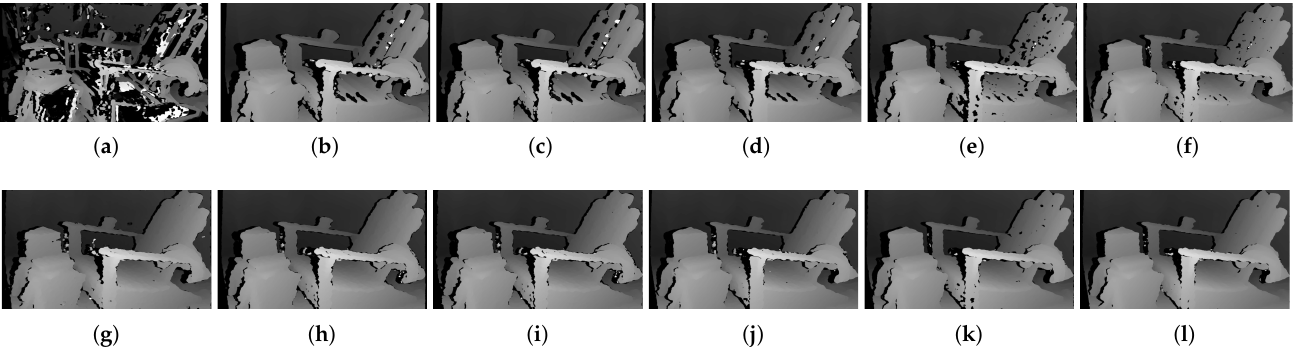
Figure 9. Estimated disparity images of the combinations of cost and image filter using the window- based stereo method, according to the low and high pattern intensity parameters. The images in the top row show disparities at the low intensity parameter, and the images in the bottom row show those at the high intensity parameter, respectively. ( a ) Window, SAD. ( b ) Window, Mean/SAD. ( c ) Window, LoG/SAD. ( d ) Window, BilSub/SAD. ( e ) Window, Rank/SAD. ( f ) Window, Census. ( g ) Window, SAD. ( h ) Window, Mean/SAD. ( i ) Window, LoG/SAD. ( j ) Window, BilSub/SAD. ( k ) Window, Rank/SAD. ( l ) Window,